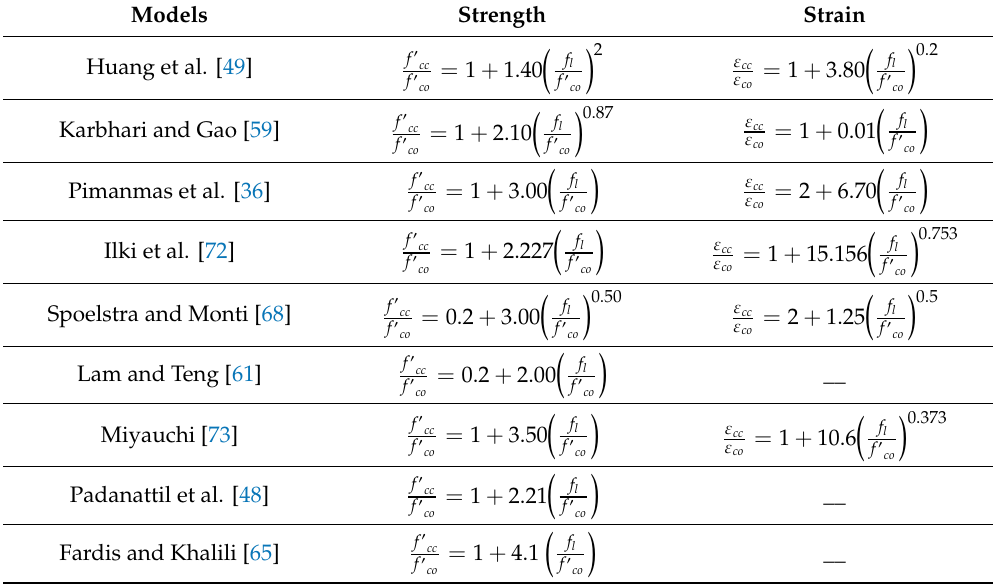
Table 8. Existing strength and strain models for FRP-confined circular specimens. Models